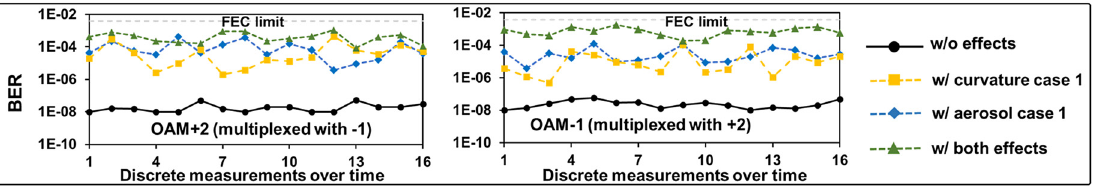
Figure 8: The BER performance of the OAM − 1 and + 2 under various interface effects. The measurement of each data pointtakes>30s.Wenotethattheinterface conditions could be slightly different for all these measurements due to the dynamics of the aerosol and curvature. The incident angle is 0